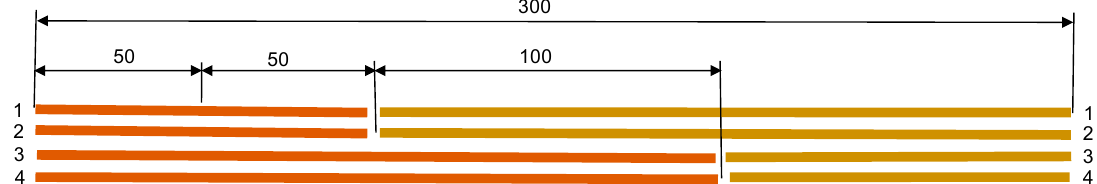
Figure 8. Schematic view of the specimen prepared for splice shear strength tests. Test specimens were 30 mm × 300 mm in size and have cuts in their two upper plies and two bottom plies. The cuts were 100 mm in length. The specimens were placed in the clamps of the testing machine and tensioned with a speed of (100 ± 10) mm/min until the specimen is broken.